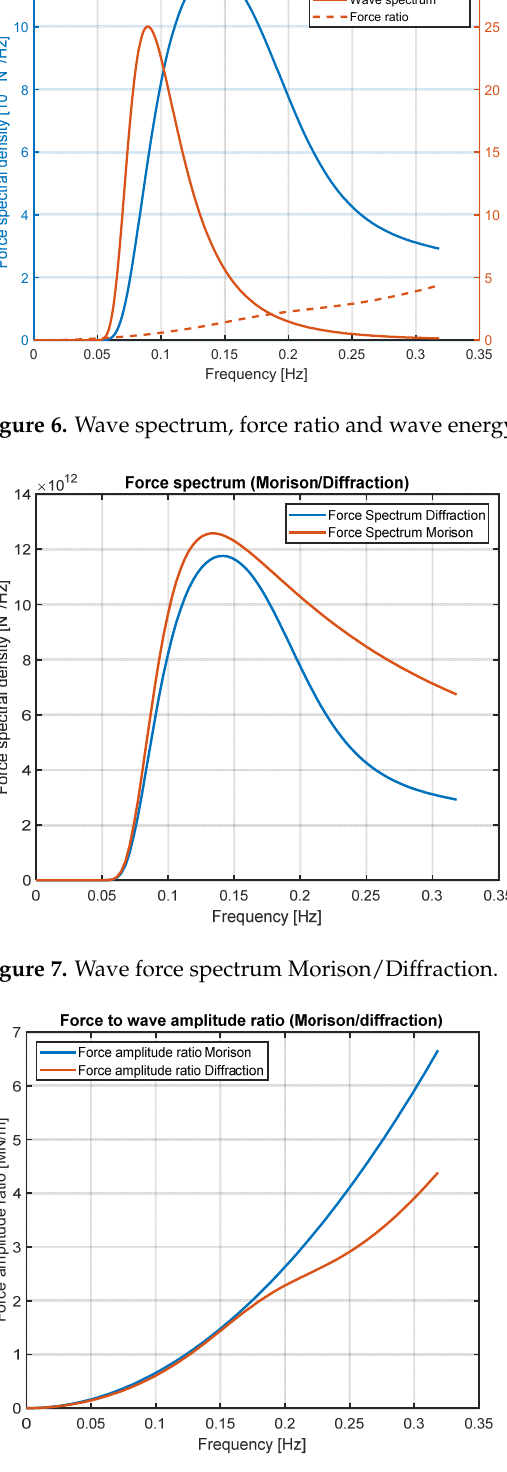
Figure 8. Force wave amplitude ratio Morison/Diffraction.